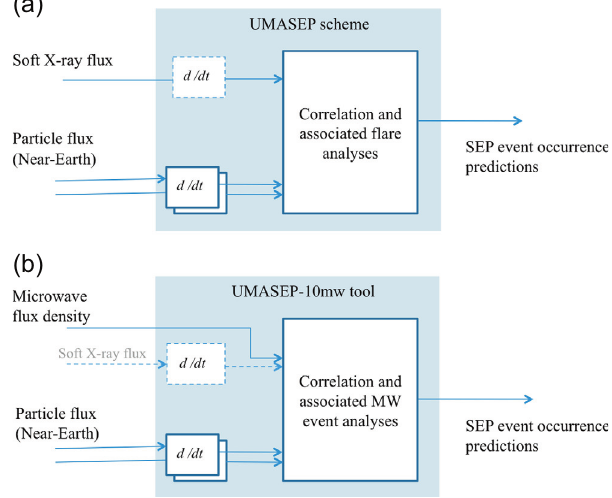
Fig. 1. Schematic of the correlation process of the Well-Connected SEP forecasting module of the UMASEP scheme. (a) UMASEP-10, which correlates the time derivative of soft X-ray flux with the time derivative of the differential proton fluxes in different energy channels observed by the GOES spacecraft (9–500 MeV). (b) UMASEP-10mw, which uses the microwave flux density instead of the soft X-ray